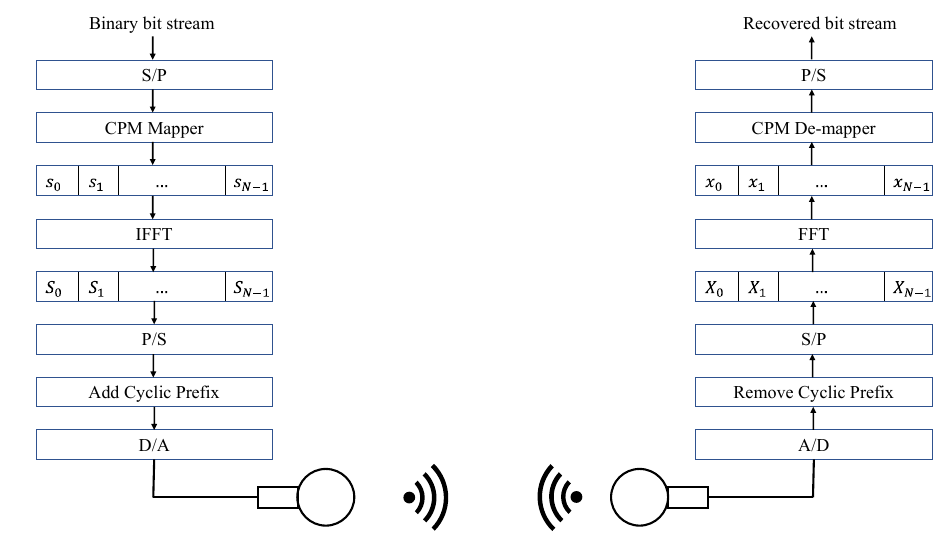
Figure 1. Proposed CPM-OFDM transceiver for underwater acoustic channel.